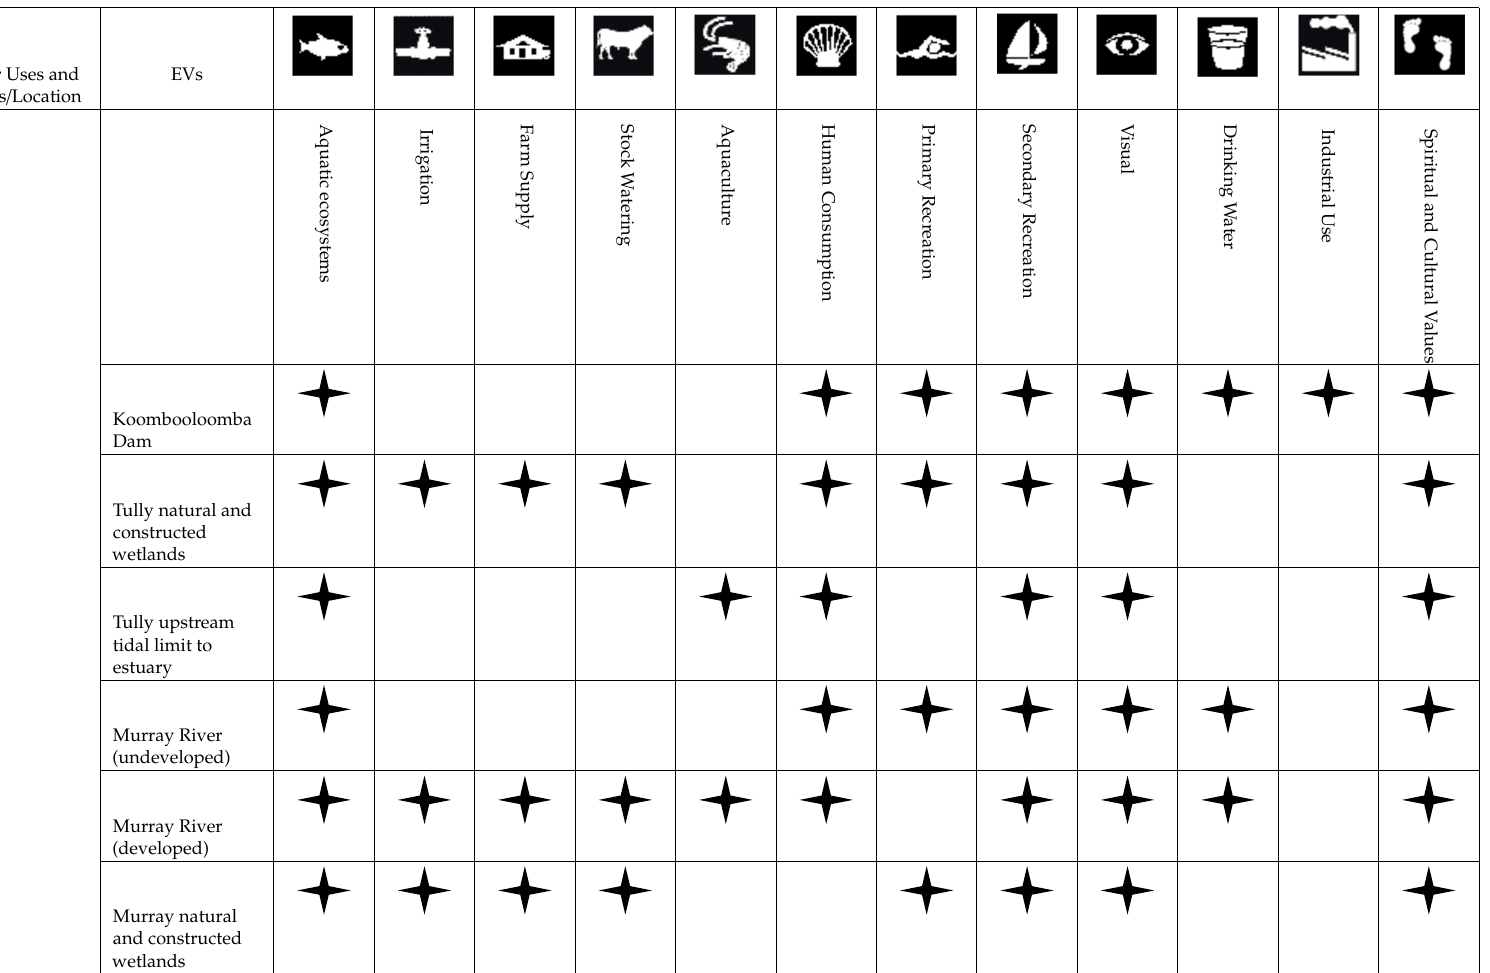
Table A2. List of EVs * Summarised for the Tully Basin EVs (as a result of this current research. Table A1. List of EVs * Summarised for the Tully Basin EVs (as a result of this current research. Table A1. List of EVs * Summarised for the Tully Basin EVs (as a result of this current research. Table A1. List of EVs * Summarised for the Tully Basin EVs (as a result of this current research. Table A1. List of EVs * Summarised for the Tully Basin EVs (as a result of this current research. Table A1. List of EVs * Summarised for the Tully Basin EVs (as a result of this current research.